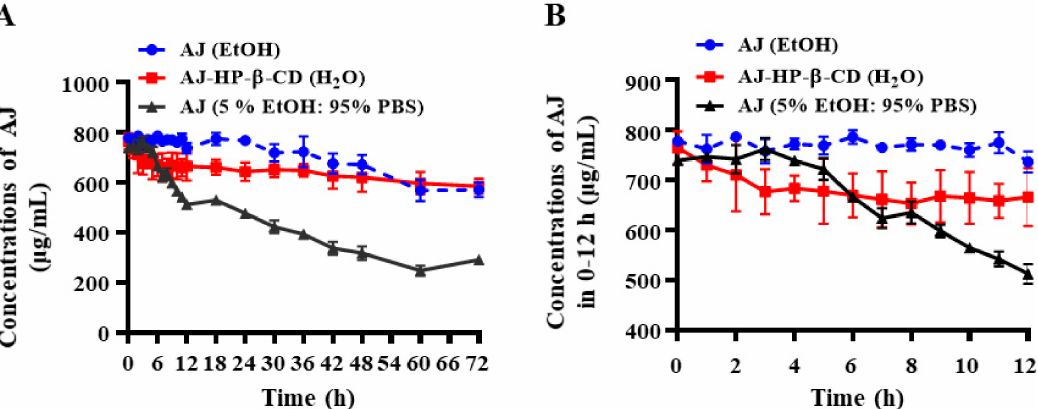
Figure 2. Stability of AJ and AJ-HP- β -CD. ( A ): The stability of AJ in EtOH (blue), AJ-HP- β -CD in water (red), and AJ in EtOH or 5% EtOH: 95% phosphate-bu ff ered saline (PBS) (grey) at room temperature in comparison to free AJ by HPLC-evaporative light scattering detector (ELSD) (mean ± SD, n = 3). ( B ): The stability of AJ in EtOH, AJ-HP- β -CD in water, and AJ in EtOH or 5% EtOH: 95% PBS during 0–12 h ( n = 4). Statistical analysis was calculated using two-way ANOVA with Tukey’s post hoc test.